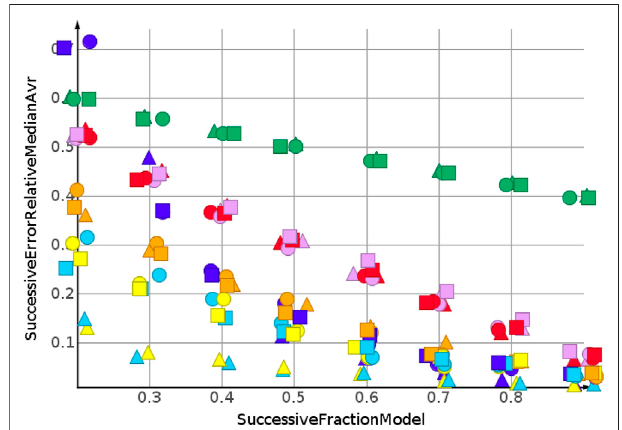
FIGURE 9 | Molecular weight, low to high sorted response values.